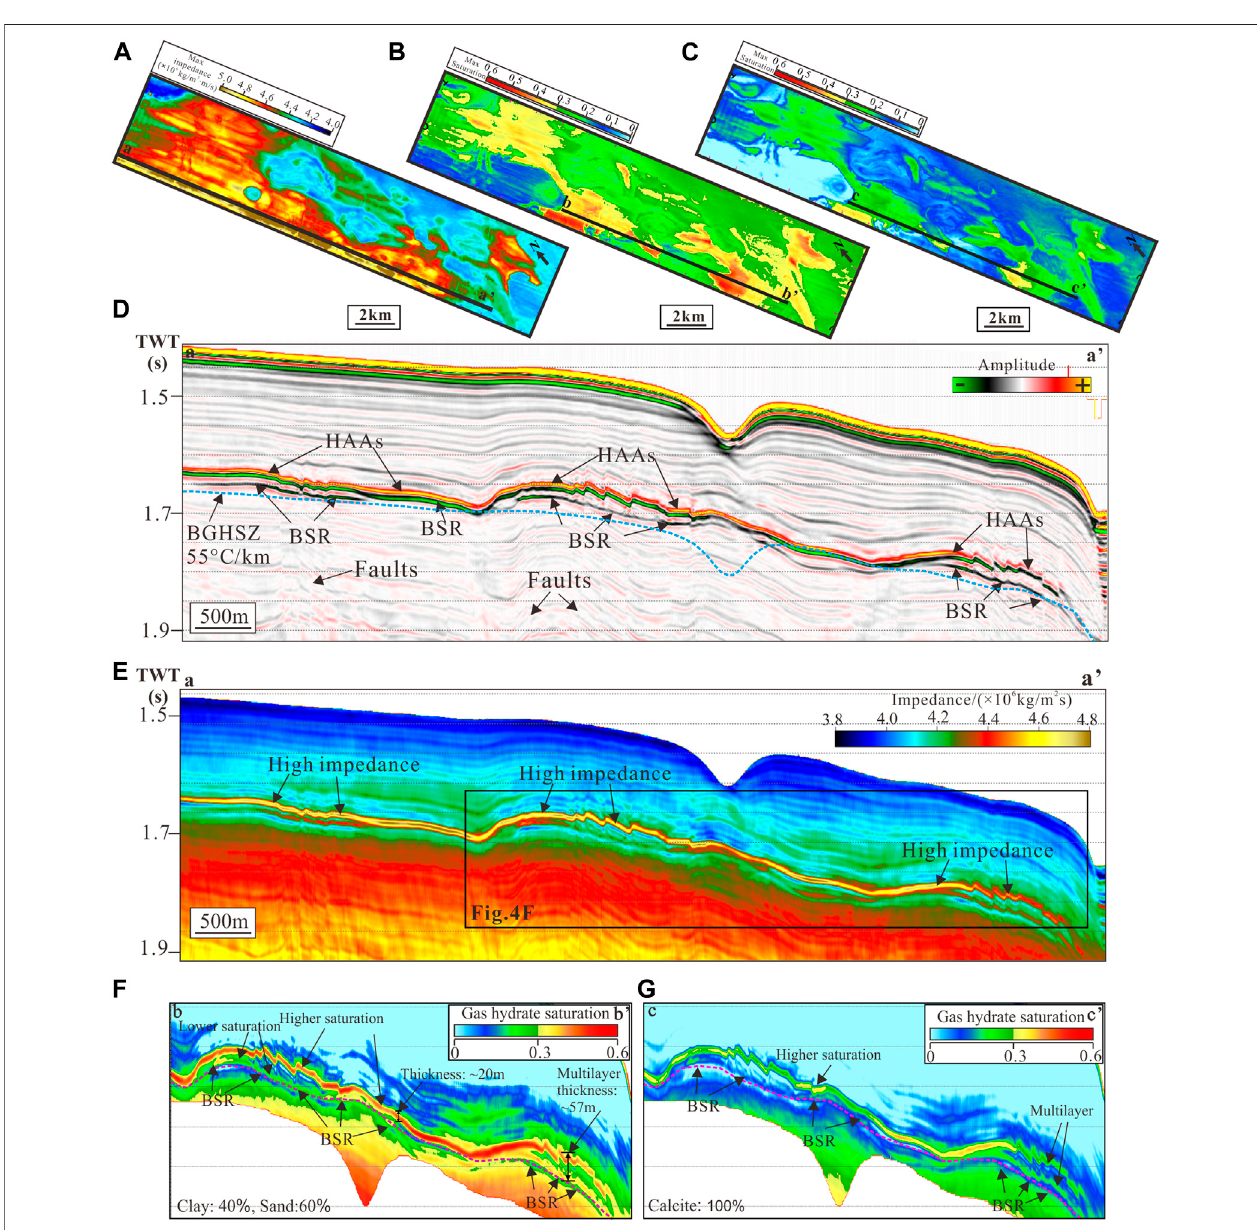
FIGURE 4 | (A) Maximum value extracted from the acoustic impedance along BGHSZ with 50 ms spanning windows, showing the distribution of the acoustic impedance. (B) Maximum value of the estimated gas hydrate saturations using the clay/sand model along BGHSZ with a 50 ms search window. (C) Maximum value of theestimatedgashydratesaturationusingamodelwith100%calcite,showingthedistributionofgashydratesaturation. (D) Thereprocessedbroadbandseismicpro fi le shows BSR and high amplitude anomalies (HAAs). (E) The inverted acoustic impedance pro fi le shows high acoustic impedance of the HAA layer (F) – (G) Gas hydrate saturation pro fi les estimated from iterative inversion using the lithologies of 40% clay and 60% sand, and carbonate, respectively.